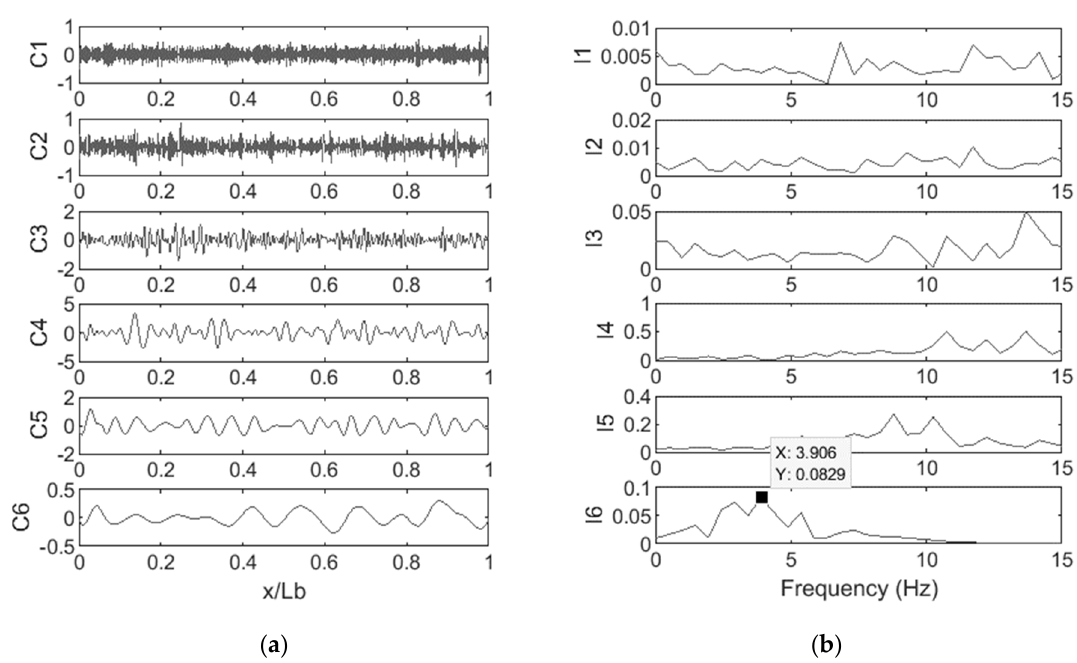
Figure 9. ( a ) IMFs obtained from the EEMD of the vehicle acceleration response and ( b ) FFT spectra of the IMFs.